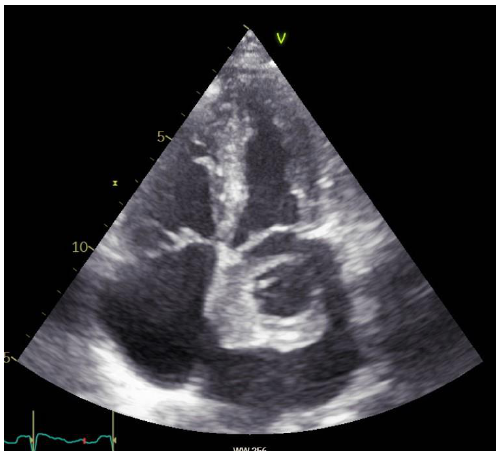
Figure 1. Echocardiographic imaging of a CM located in the left atrium.